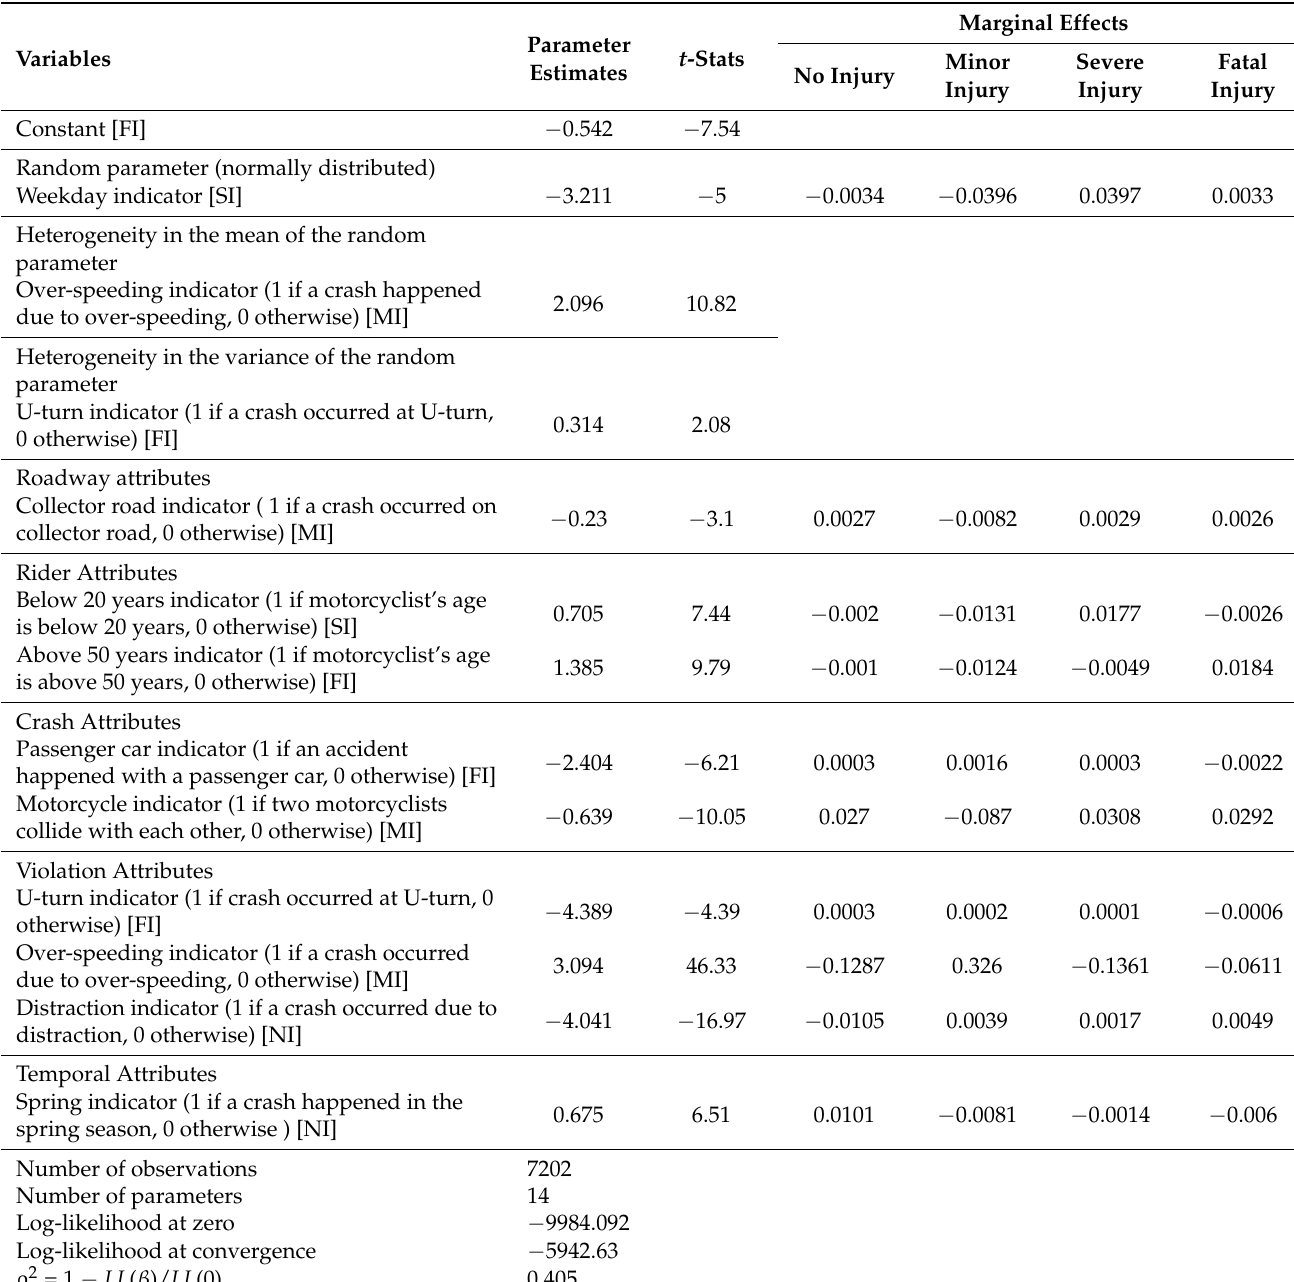
Table 11. Model estimation results for non-helmet-wearing motorcycle crashes